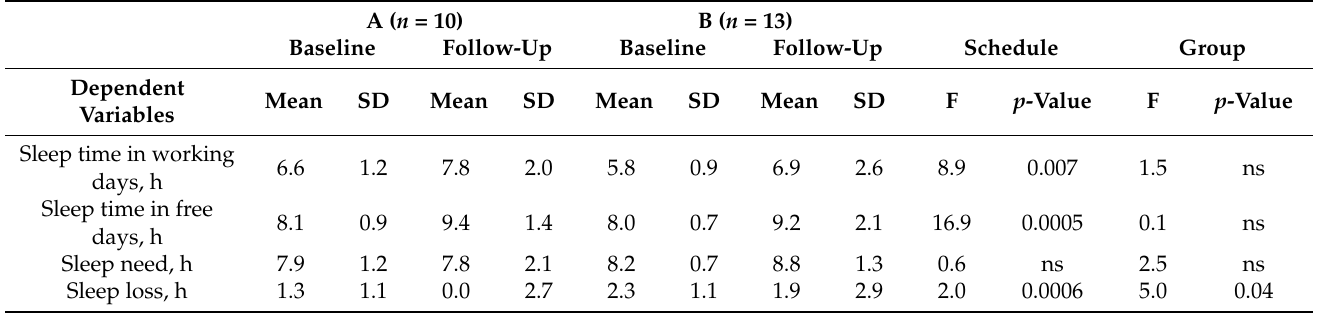
Table 2. Effects of schedule change and trial group on sleep (mean, SD) at the baseline and at the follow-up. A ( n = 10) B ( n = 13) Baseline Follow-Up Baseline Follow-Up Schedule